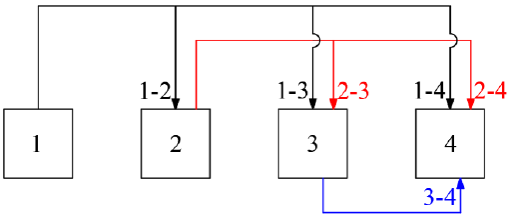
Figure 3. Schematic diagram of the classification structure.